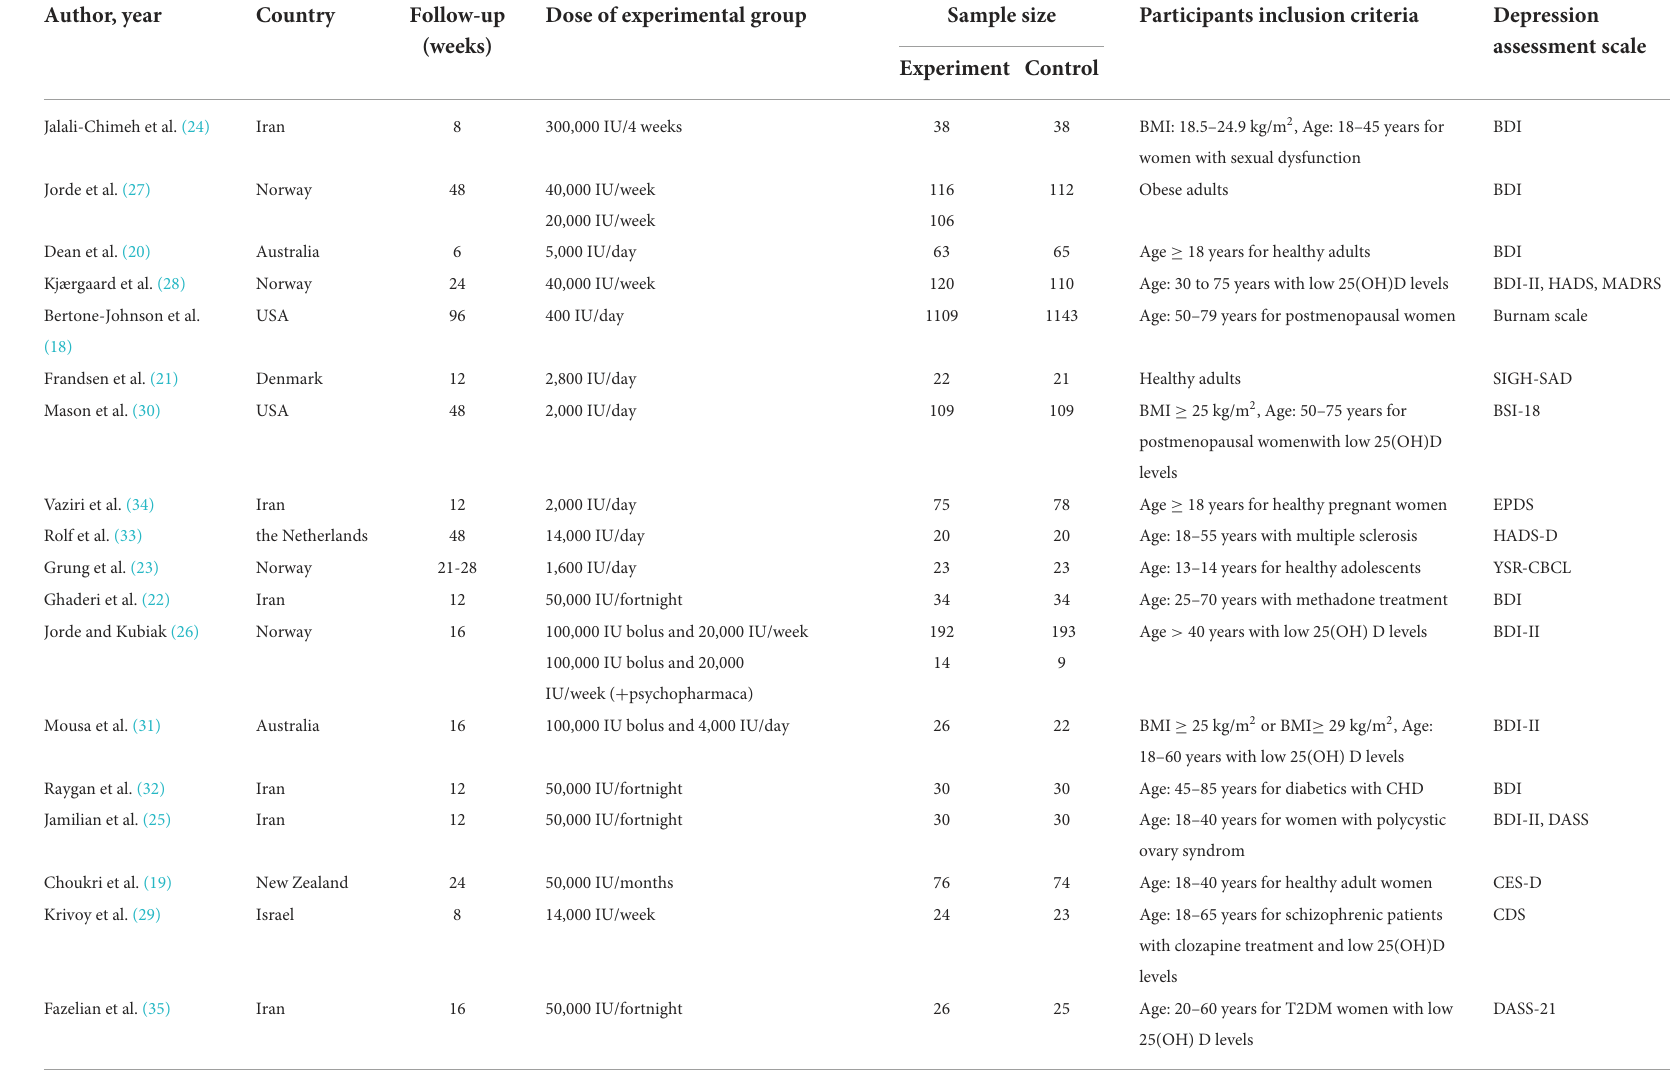
BMI, body mass index; BDI, Beck Depression Inventory; HADS, Hospital Anxiety and Depression Scale; MADRS, Montgomery-Asberg Depression Rating Scale; GDS, Geriatric Depression Scale; SIGH-SAD, The Structured Interview Guide for the